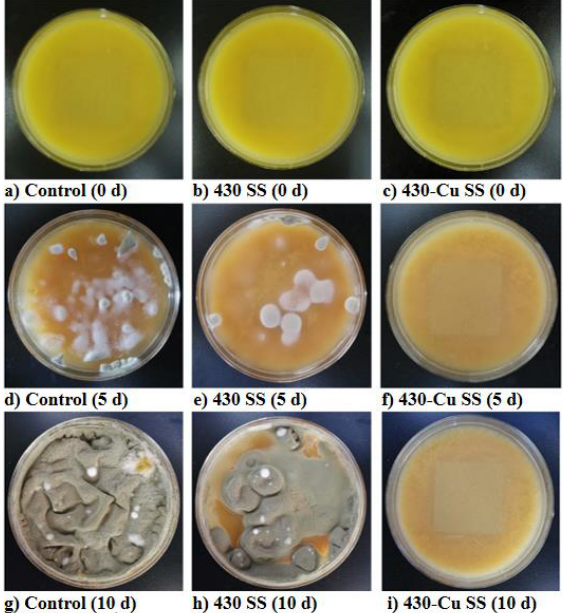
Figure 4. Macroscopic features of orange juice immersed with 430 and 430-Cu stainless steels, respectively, for 5 d and 10 d [76].